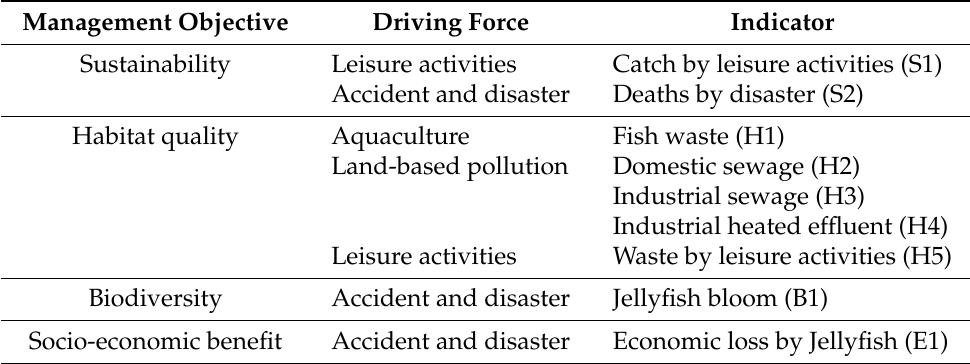
Table 1. Selected other driving forces and their indicators for the extended EBFA in the Uljin coastal